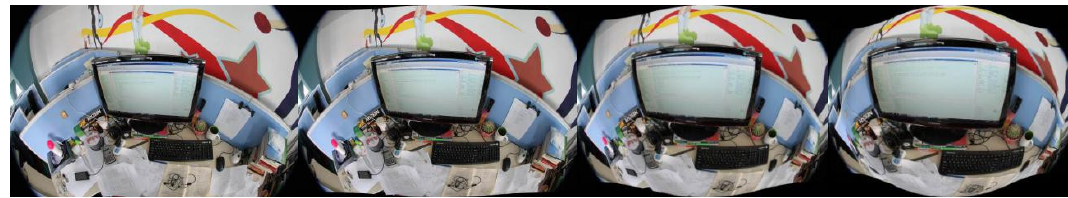
Figure 2. Test images containing varying degrees of distortion: 10%, 20%, 30%, and 40%, in order from left to right.